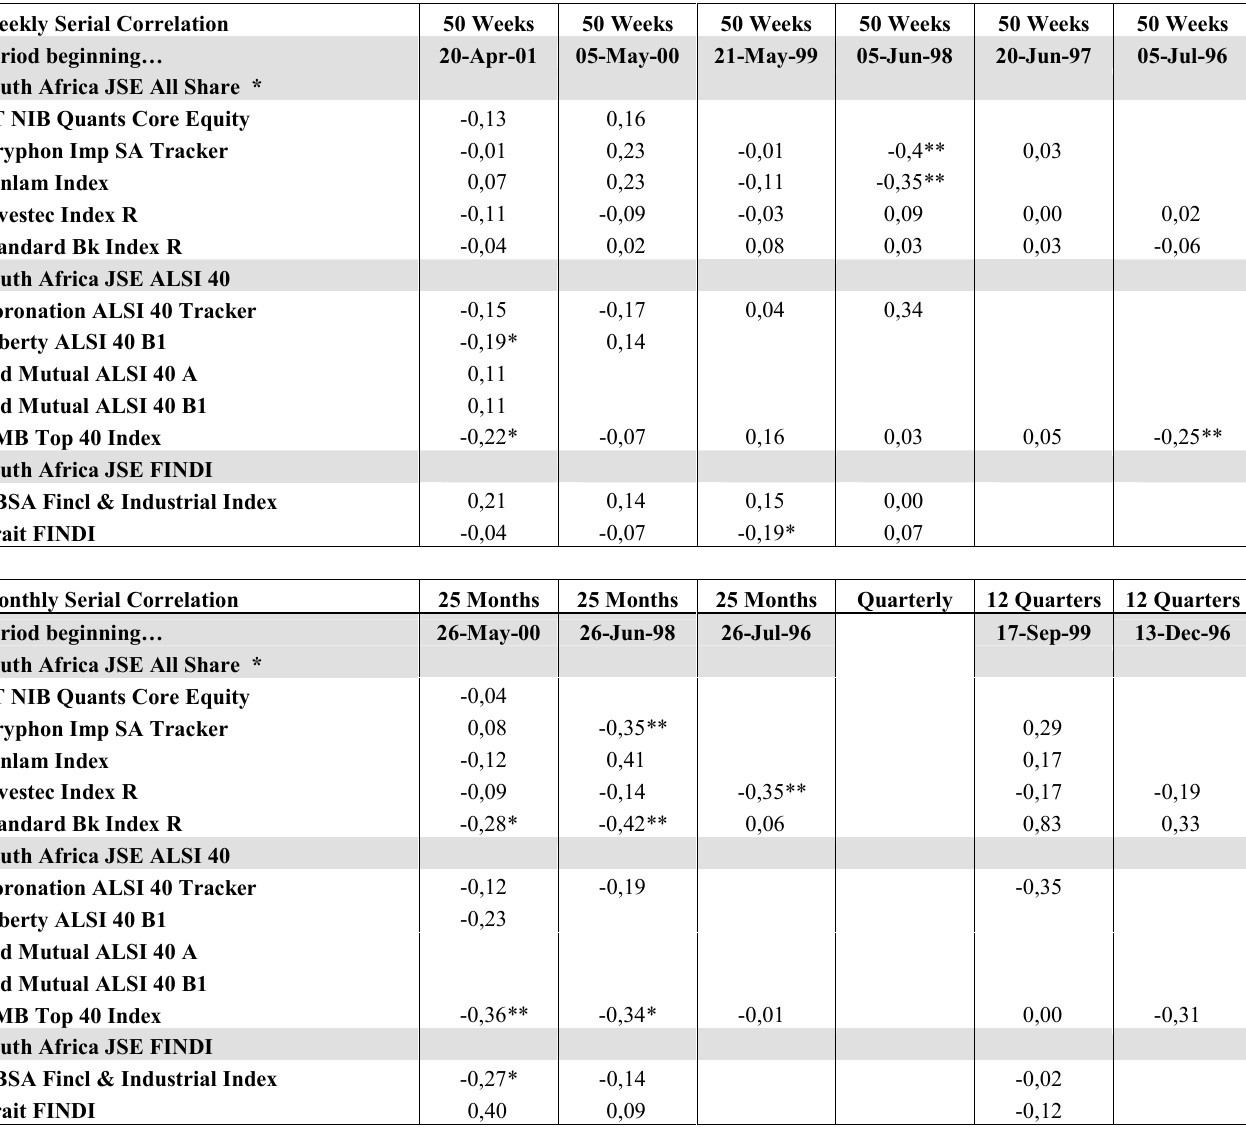
Table 2: Serial Correlation (lag = 2) of each Fund’s TE against its Benchmark for non-overlapping periods Weekly Serial